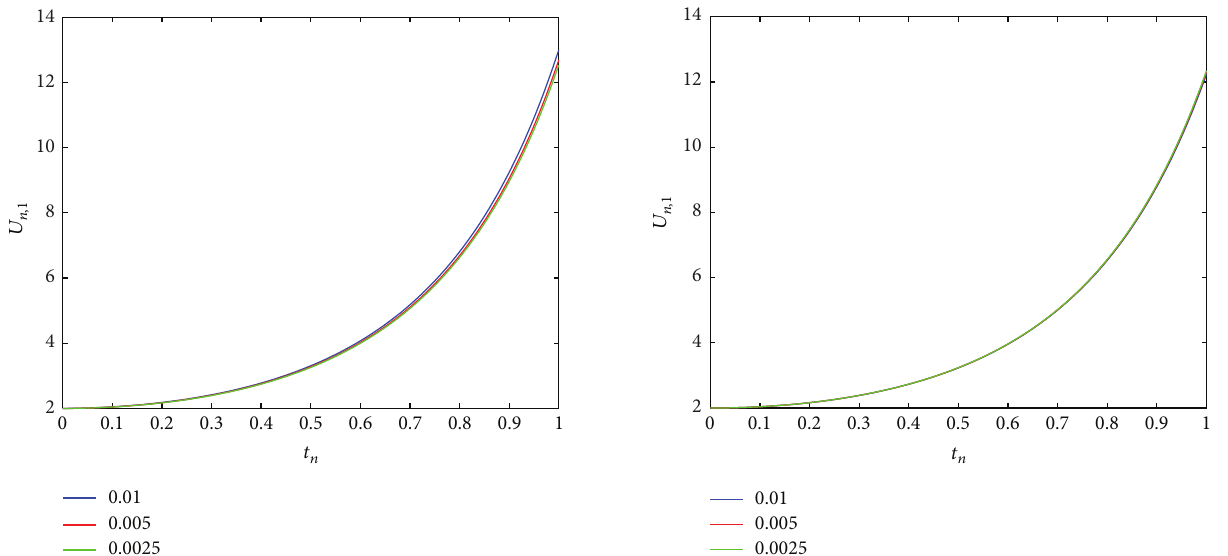
Figure 1: The collocation solution of (48) when 𝑐 1 = 1 .